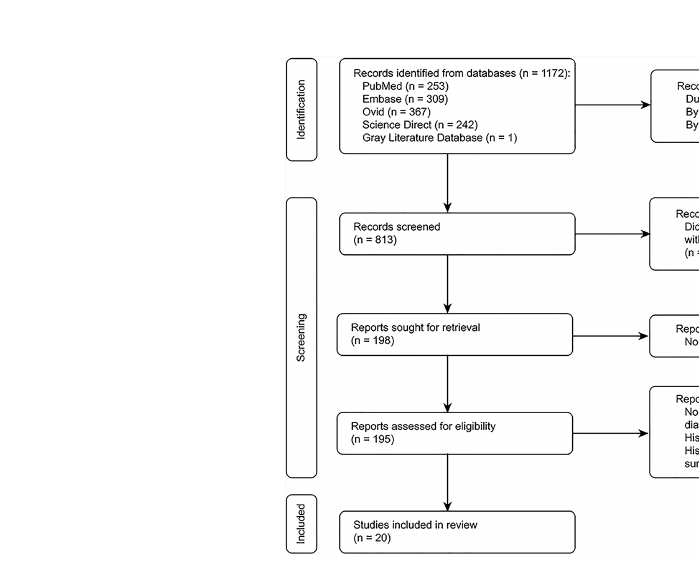
FIGURE 3 Flow chart for the systematic